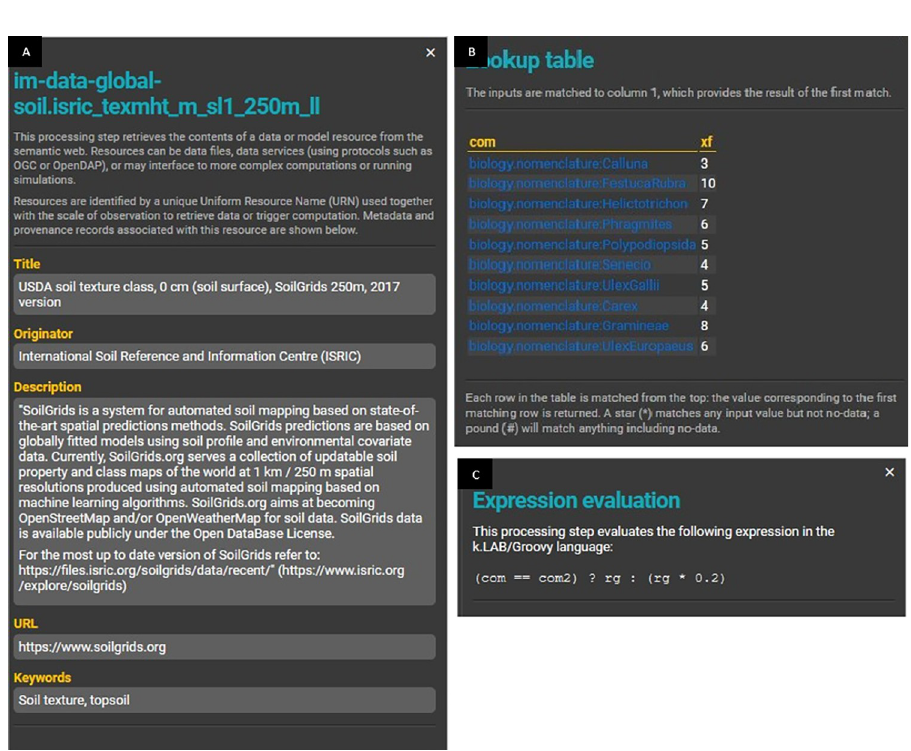
Fig 15. Example of additional dataflow component views. The individual dataflow components are shown by clicking on the boxes. (A) Information related to resources (i.e., raster data, vectorial), (B) information related to a look-up table where each ontology is linked to the identifier of the resource, (C) information related to a model equation. In this case, it is a conditional expression that indicates: when main vegetation (com) is equal to secondary vegetation (com2), then the result is the solar radiation (rg), otherwise, the result is rg multiplied by 0.2.